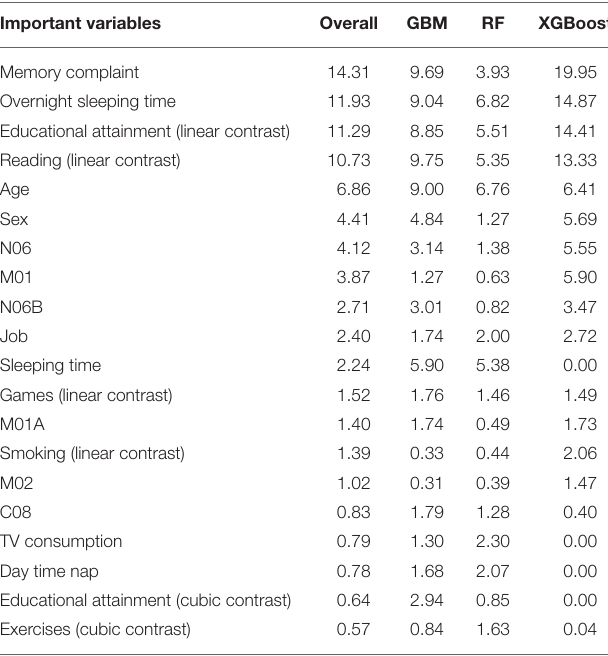
TABLE 3 | Comparison of the area under ROC curve (AUC) for several models. Method